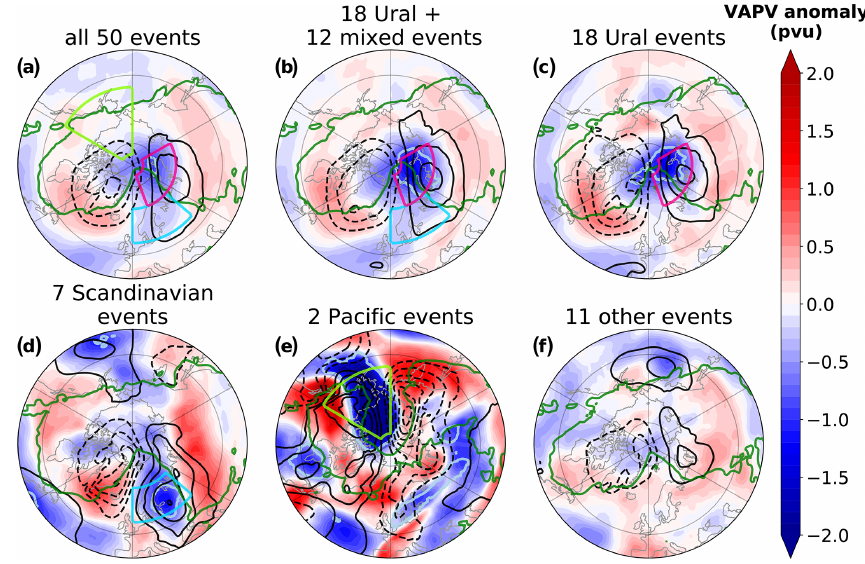
Figure 5. Circulation patterns observed during warm extremes shown as time mean composites over days − 3 to − 1 prior to the warm events for (a) all 50 extreme events; (b) 30 events with Ural blocking, comprised of 18 pure Ural events and 12 events within the mixed cluster; (c) 18 pure Ural events; (d) 7 pure Scandinavian events; (e) 2 Pacific events; and (f) remaining 11 events belonging to the other cluster. Shown are VAPV anomalies (pvu, shading) overlaid with SLP anomalies (hPa, black contours every 5hPa, dashed for < 0hPa, zero line not shown), total column water (green solid isoline for 5kgm − 2 ), and blocking frequency for the events and respective time steps involved in each composite (light-blue solid contour for 33%). The colored boxes in panel (a) show the Ural (magenta), Scandinavian (blue) and Pacific (light green) sectors. Table 1. Coordinates for the sectors used in the event clustering (left) and other defined regions used in this study (right).